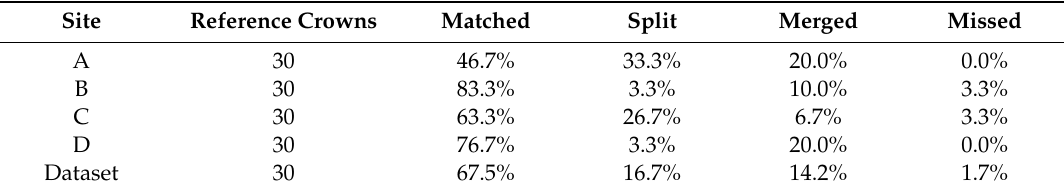
Table 4. Report of the trees’ detection accuracy with the number of estimated trees and its detection type in the four